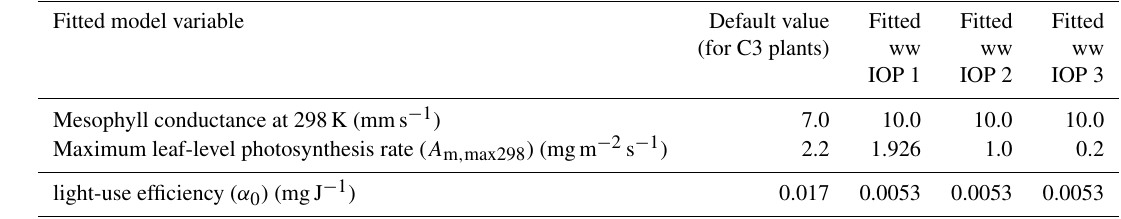
Table 3. Parameters representing the maximum leaf-level photosynthesis rate ( A m , max298 ) and the initial value of light-use efficiency ( α 0 ) under low light, as adjusted in the original A – g s model to represent plant-specific photosynthesis characteristics for winter wheat (ww). A m , max298 was initially fitted using the A –Ci curves and α 0 is fitted using the A –PAR curves taken during IOP 1 (Fig. 5). For IOP 2 and IOP 3, A m , max298 values were fitted only on leaf-level measurements of A max . The values of IOP 1 were used as numerical settings for the CLASS model runs (Fig. 16). The equivalence to typical values of the commonly used in the Farquhar–Berry–von Caemmerer (FBvC) model of leaf photosynthesis (Farquhar et al., 1980) is given in Table S1 at the Supplement. Fitted model variable Default value Fitted Fitted